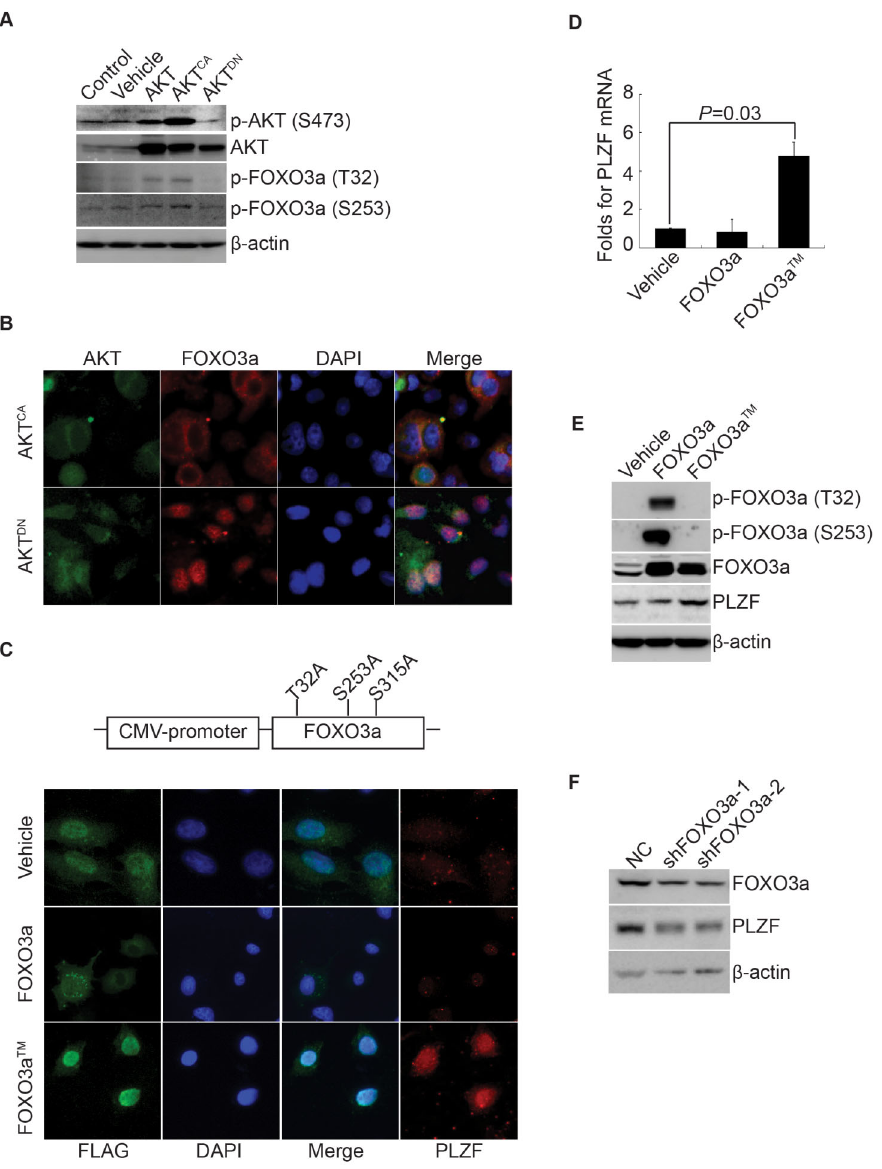
Figure 3. FOXO3a regulates PLZF expression in prostate cancer cells. A. Wild-type AKT, AKT CA , and AKT DN were transfected into PC3 cells, and Western blots were performed with the proteins as indicated. B. AKT CA and AKT DN were transfected into PC3 cells, followed by immunofluorescent staining of AKT and FOXO3a with re-stain of DAPI. The representative images were recorded under a 40 6 objective. C. Flag- tagged FOXO3a and FOXO3a TM were transfected into PC3 cells, followed by immunofluorescent staining of Flag and PLZF with re-stain of DAPI. The representative images were recorded under a 40 6 objective. D, E. Wild-type FOXO3a and triple mutant, FOXO3a TM were transfected into PC3 cells respectively, and Q-PCR (D) and Western blots (E) were performed as indicated. In panel D, folds of PLZF mRNA against cells transfected with vehicle were calculated, and results were shown as means with bar as SD in three independent experiments with triplicate each. The P values for comparison between line-linked groups were gotten by Student’s t -test. F. ShRNAs specifically against FOXO3a along with its non-specific shRNA (NC) were respectively transfected into LNCaP cells, and Western blots were performed with FOXO3a and PLZF with b -actin as loading control. All the experiments were repeated individually for three times. we confirm this correlationship of PTEN and PLZF in PCa cell lines. Restoration of PTEN in PTEN-null prostate cancer cell lines dramatically upregulated PLZF expression along with the inhibition of AKT phosphorylation, indicating that PTEN is an upstream regulator on PLZF expression. After the treatment with PI3K inhibitor, LY294002, PLZF expression is upregulated in both mRNA and protein levels in LNCaP and PC3 cells. Thus, PLZF is involved in the PTEN/PI3K/AKT pathway in PCa cells.